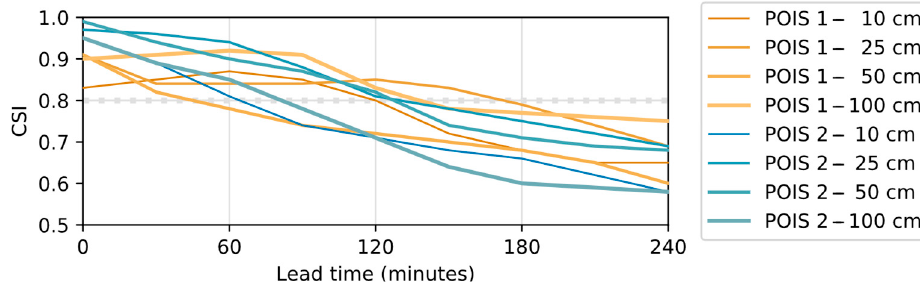
Figure 9. CSI values on predicting the exceedance of the water depth over different thresholds at the two POISs. A threshold of 0.8 CSI is considered as minimal for a forecasting system to be considered useful.